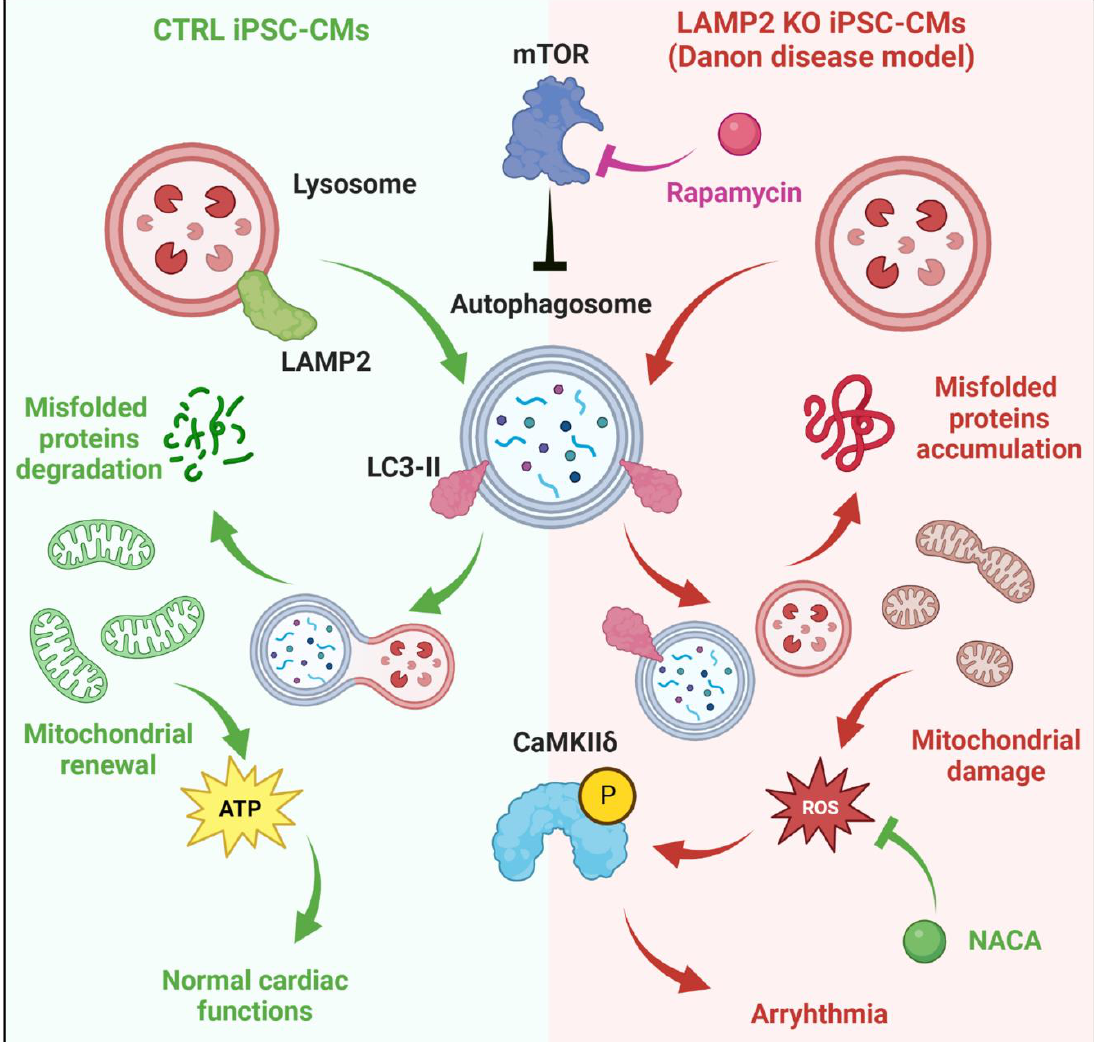
Figure 8. Diagram of the cellular mechanisms of arrhythmogenesis in DD cardiomyocytes. Left: in healthy cardiomyocytes, active autophagy mechanisms maintain the protein homeostasis and mitochondrial function. Right: in Danon disease, the lack of LAMP2 impaired the maturation of lysosome and its fusion with autophagosome, result in the accumulation of misfolded proteins and damaged mitochondria. Moreover, the increased demand of contractile function in response to increased adrenaline level (in patients) or to MM (in iPSC-CM model) will exaggerate the autophagic stress. Damaged mitochondria lead to ROS overload and overactivation of CaMKII δ , which is known to be a key regulator during the pathogenesis of cardiac remodeling and arrhythmia.